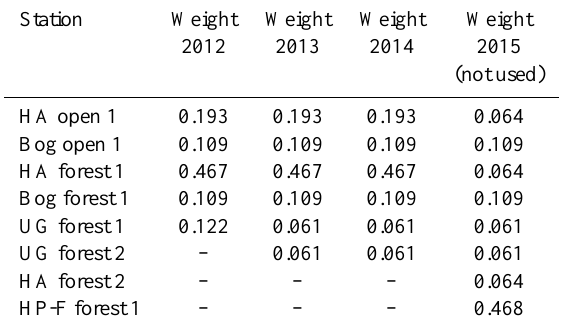
Table 2. The respective areal averaging weights used in ESA CCI data comparison/year for each in situ observation